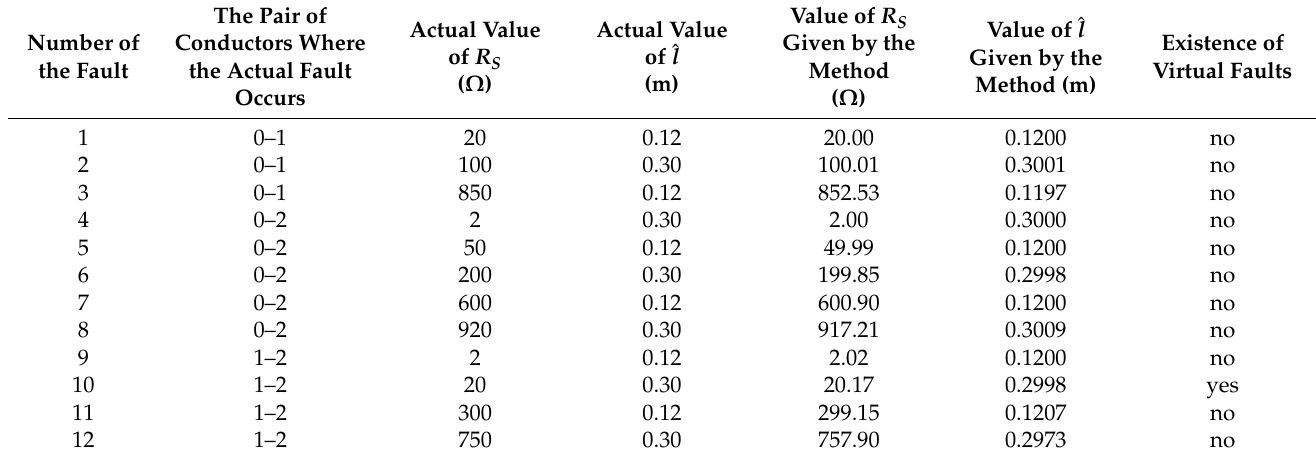
Table 1. Outcomes of the soft shorts diagnoses in the circuit of Figure